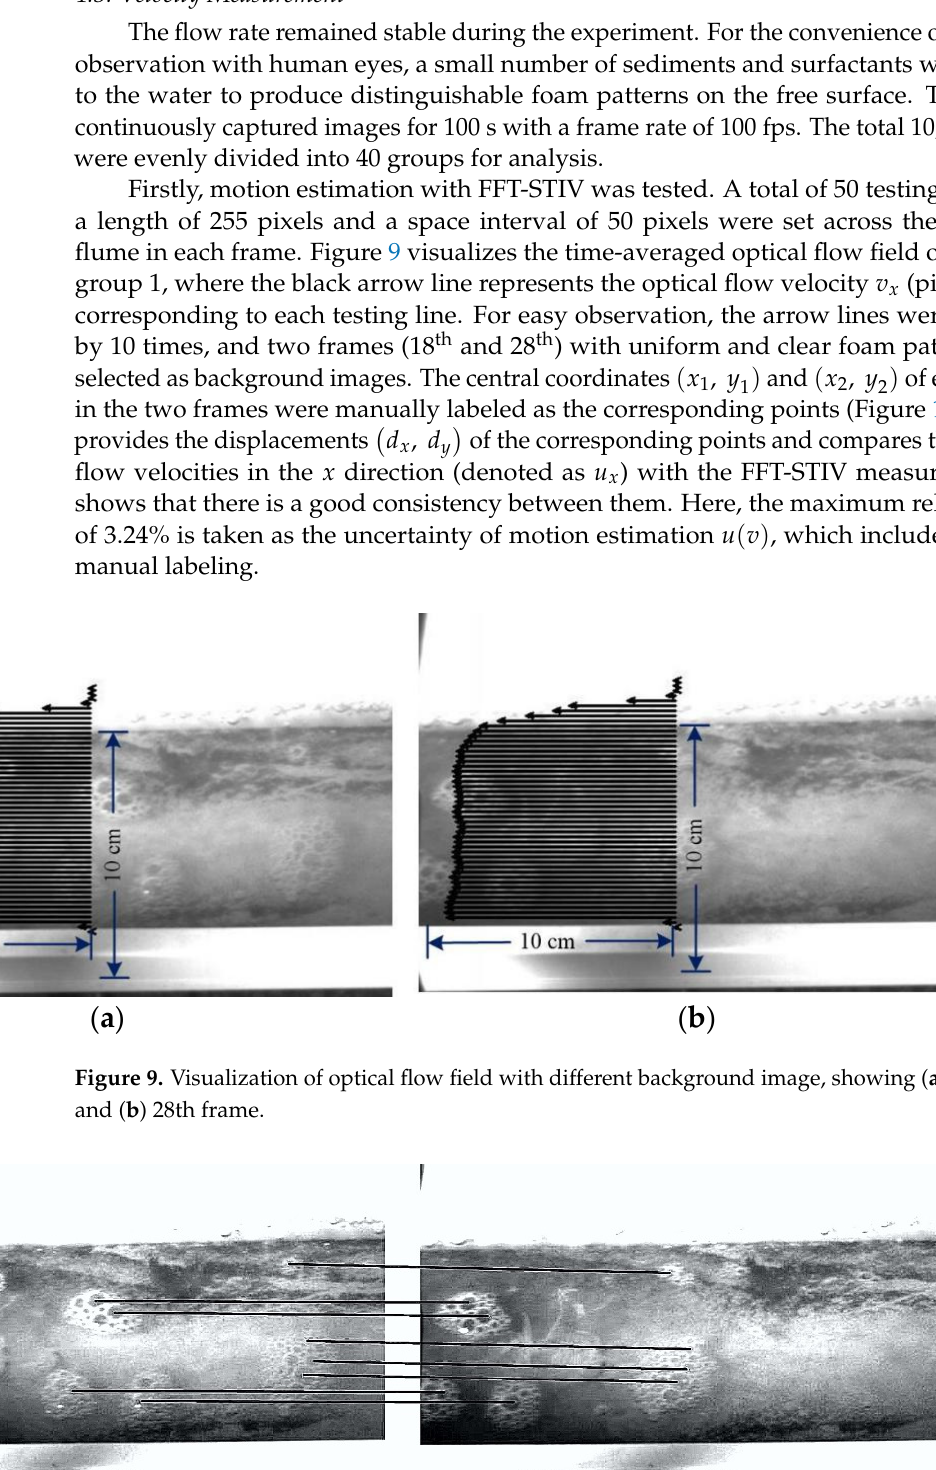
Table 6. Comparison of visual measurements and FFT-STIV measurements.